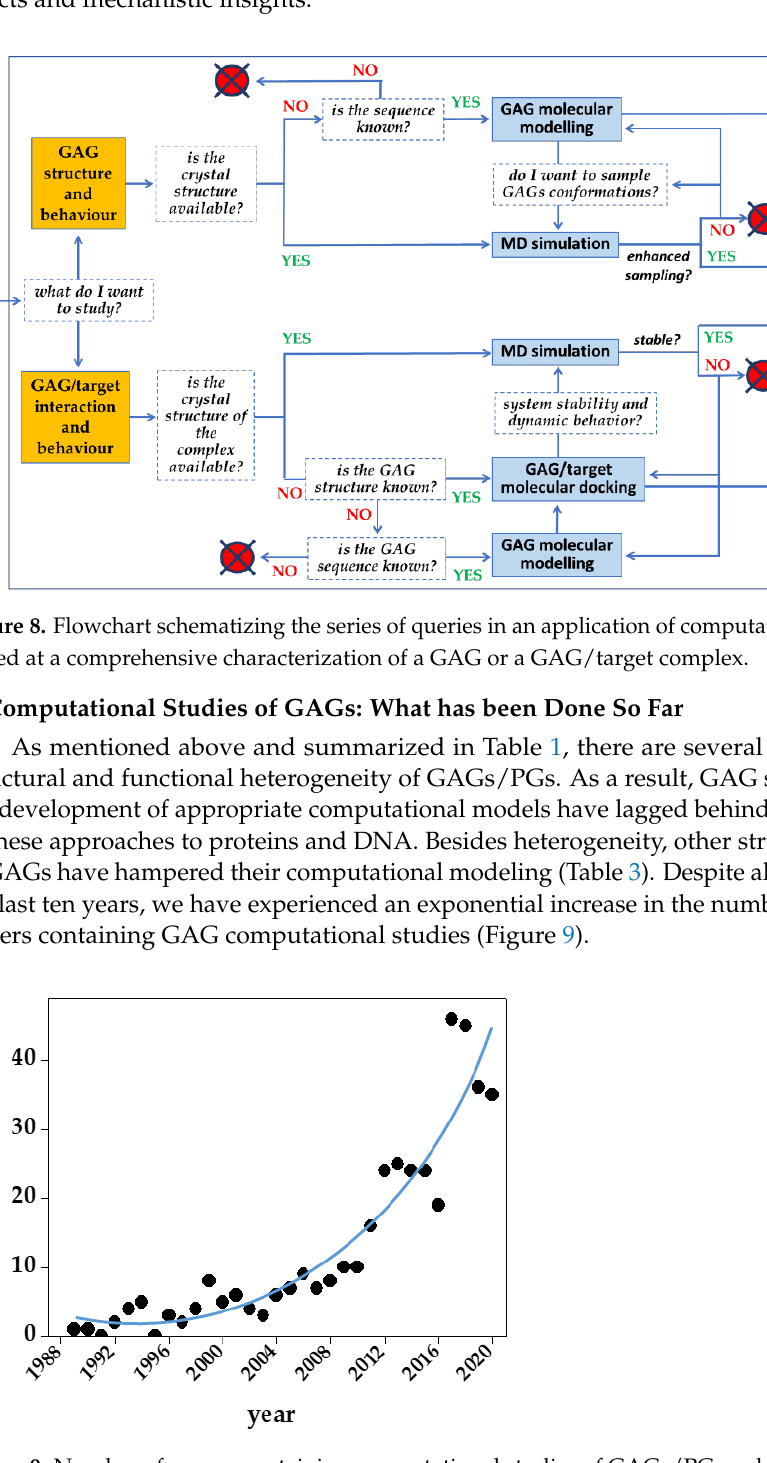
Figure 9. Number of papers containing computational studies of GAGs/PGs published since 1985. For further details on the bibliographic research strategy, see Appendix A.